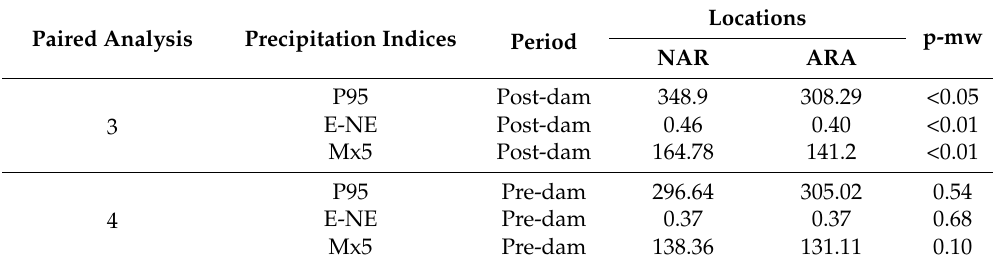
Table 7. Statistical difference tests for the mean in the extreme rainfall indices (P95/mm, E–NE (fraction) and Mx5/mm) from weather stations for the different